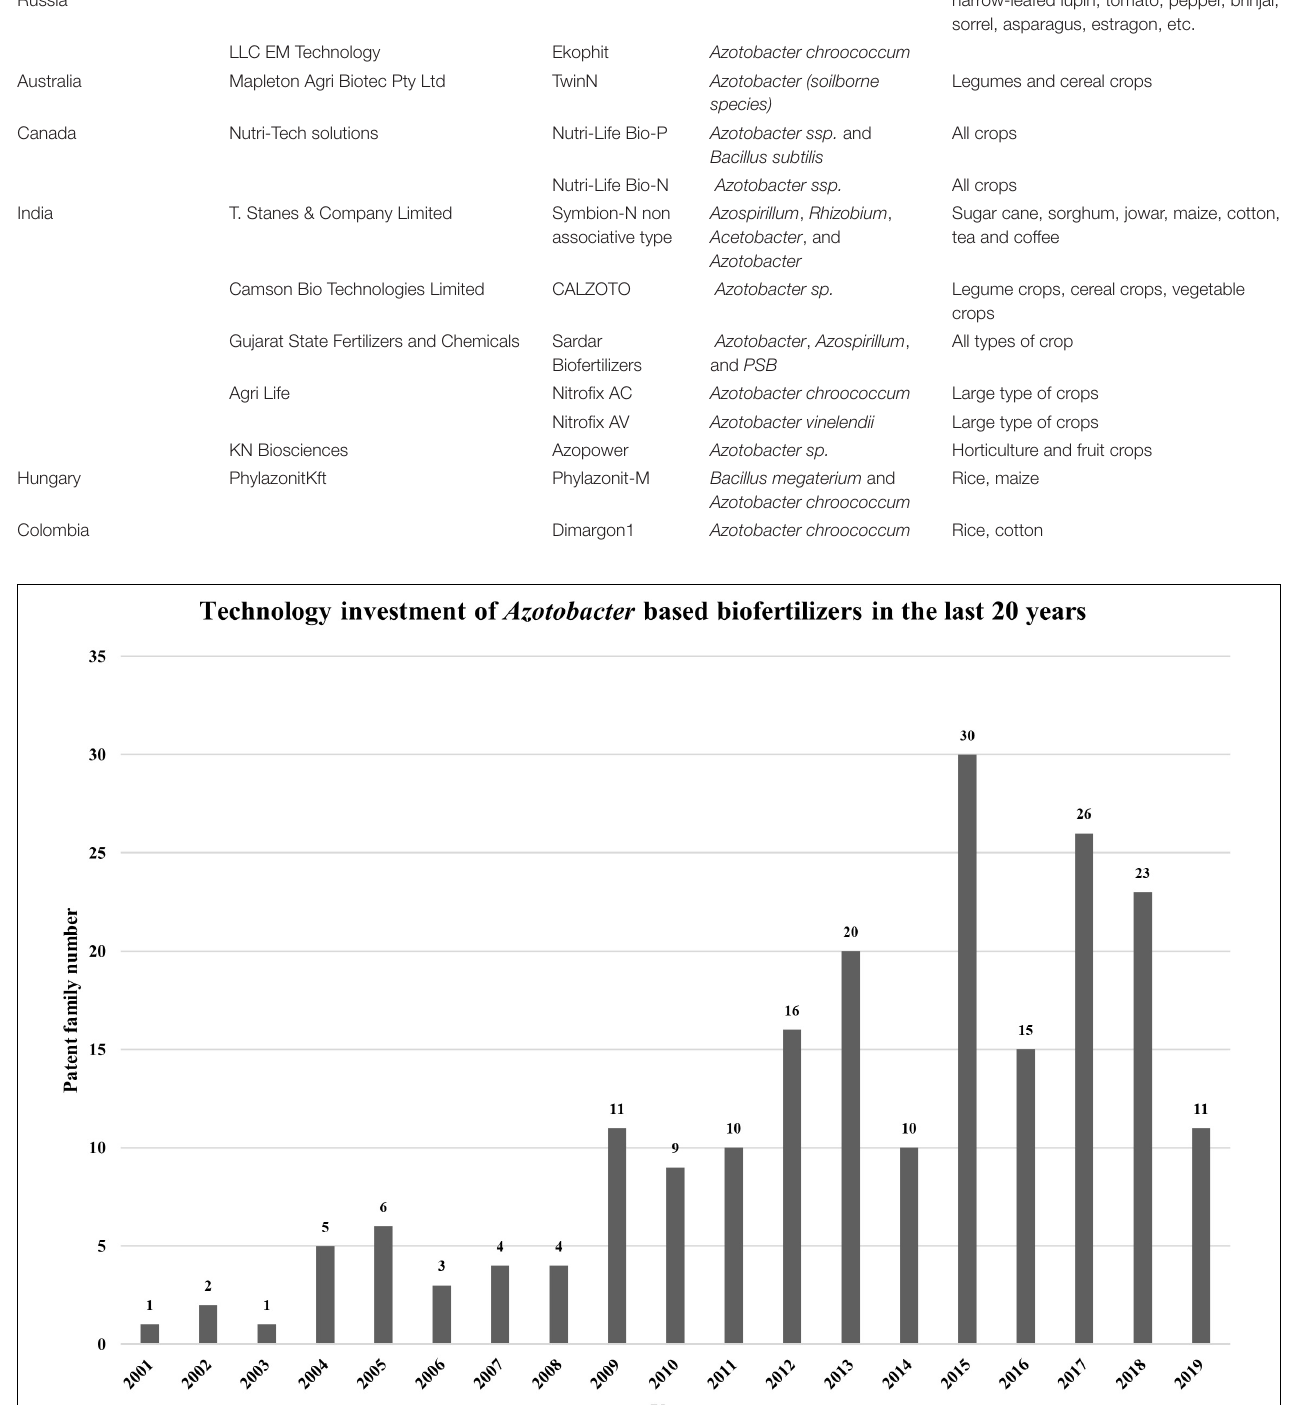
Frontiers in Microbiology |